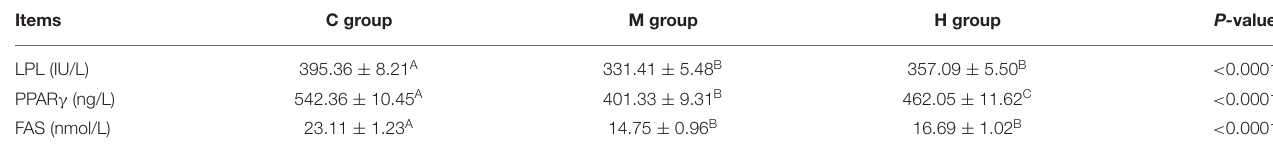
TABLE 8 | Effects of folic acid supplementation in basal diets on LPL, PPAR γ , and FAS contents in abdominal fat of broilers ( n = 6). Items C group M group H